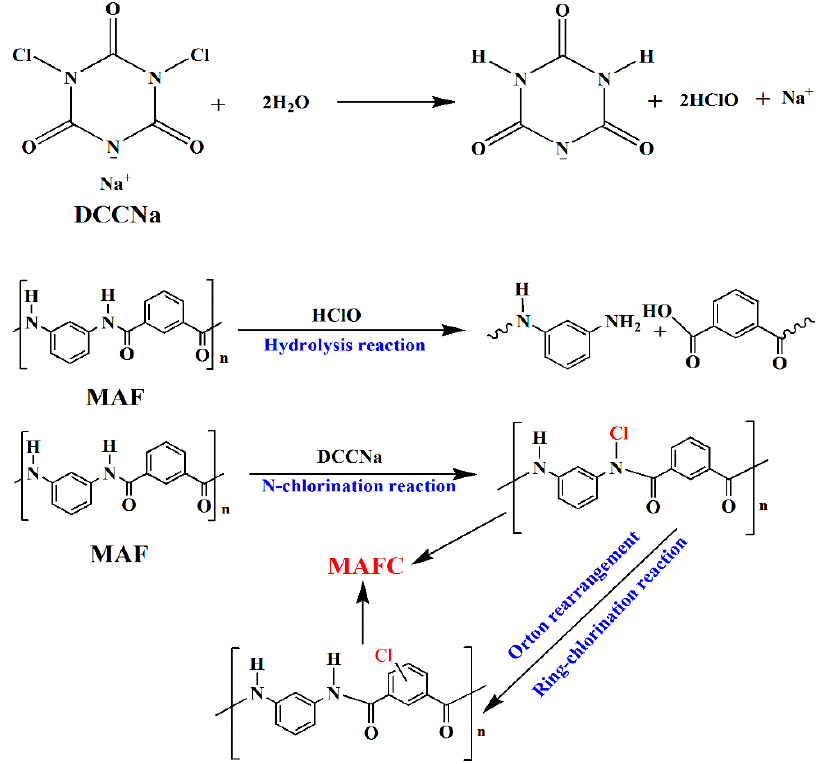
Figure 3. Mechanism of chlorination treatment in MAFC.